Question: In one sentence, what is this figure communicating?
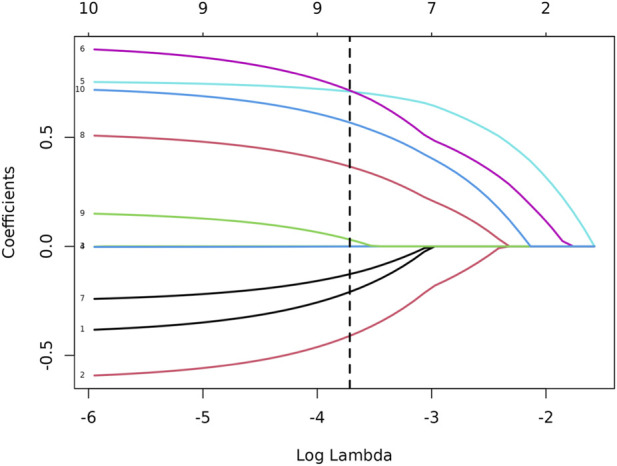
Answer: Plot of the Lasso coefficient profiles (λ = 0.0243341096455763).